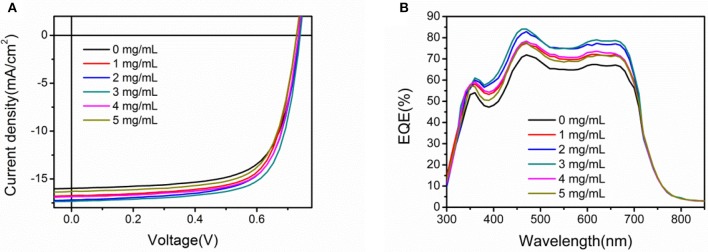
(A) Illuminated J-V characteristics and (B) EQE spectra in inverted PSCs using different concentrations U-ZnO as the ETLs. The structure of PSCs is ITO/ETL(40 nm)/PTB7:PC71BM(95 nm)/MoO3(5 nm)/Al(80 nm).